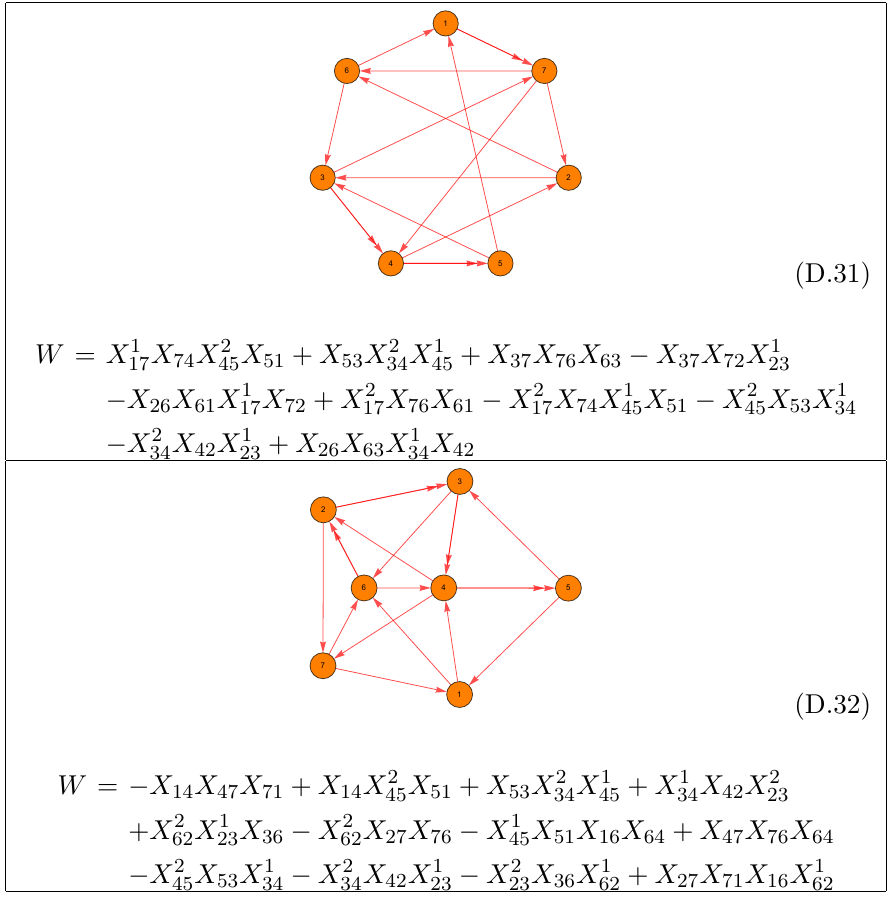
Table 5. The remaining toric phases of (5.2) in section